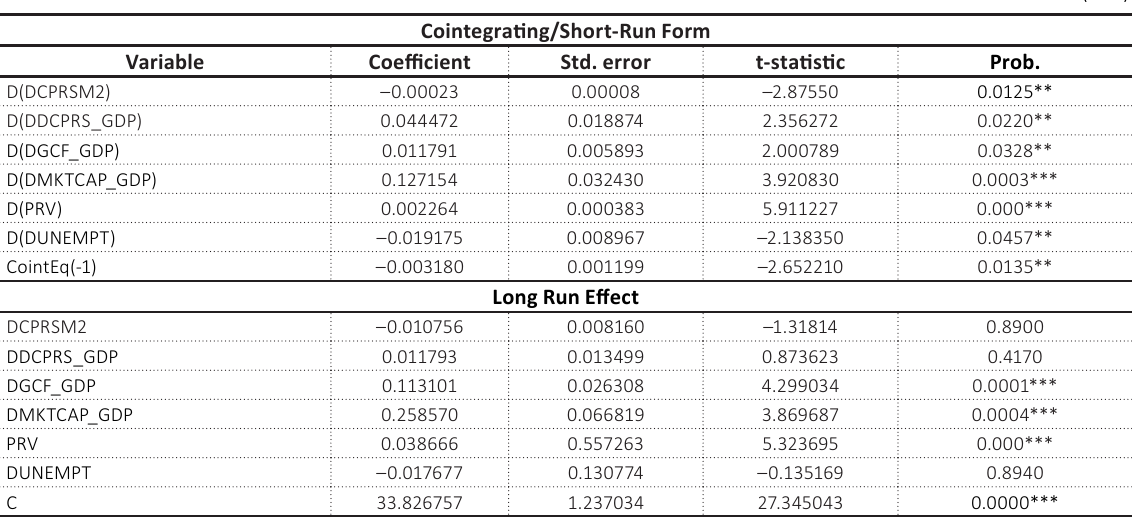
Source: World Bank